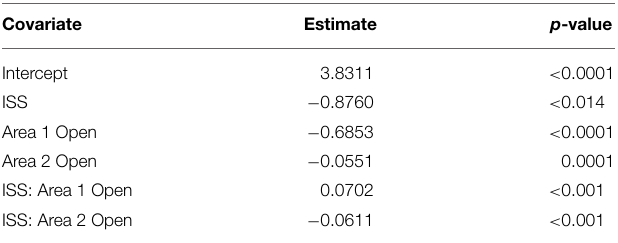
(range 12–17 in Area 1 closed, 14–16 Area 2 open, range of difference −